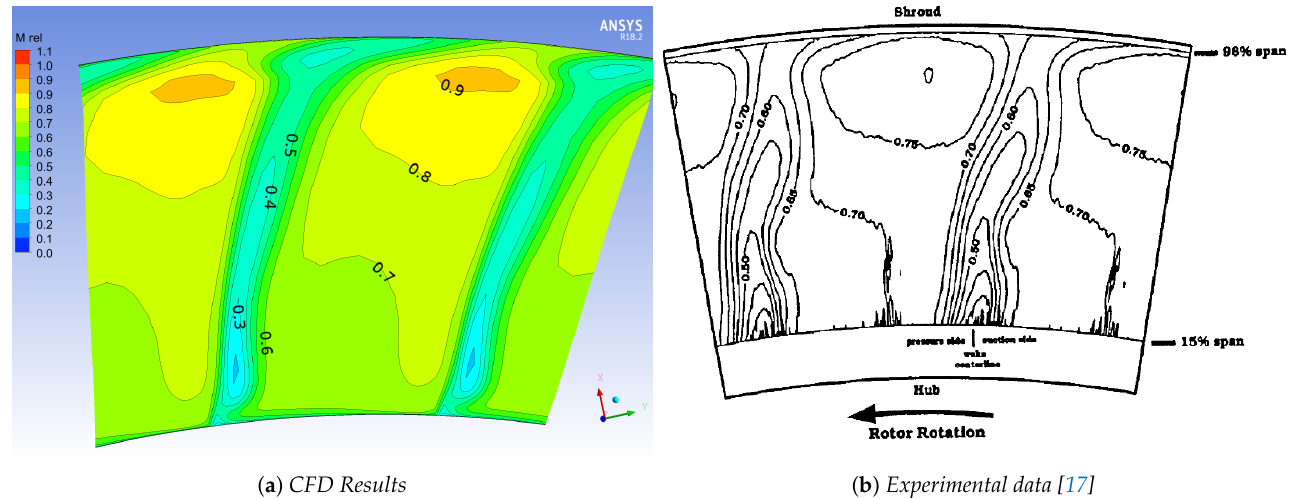
Figure 12. Contour of relative Mach number in a cross-channel plane downstream from the blade.